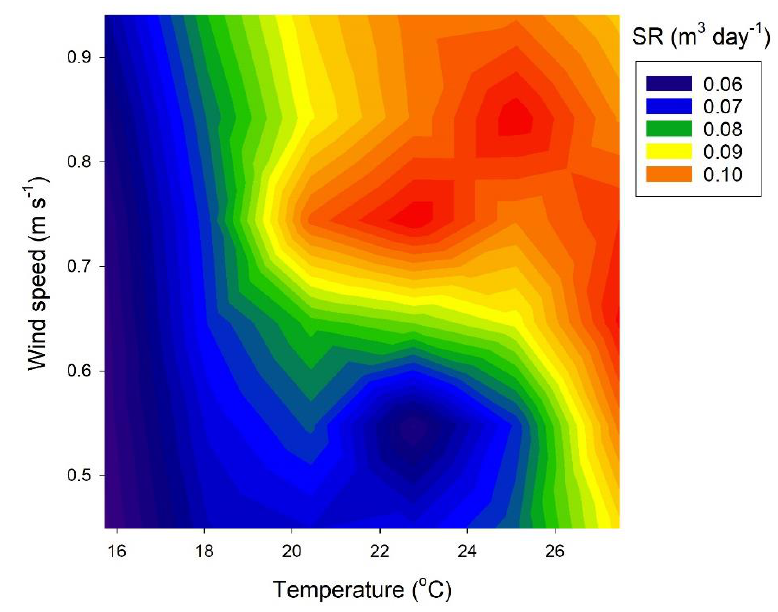
Figure 9. The contour plot for wind speed, temperature, and experimental sampling rate.